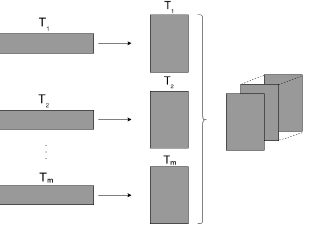
Figure 4. Data transformation to 2D representation.